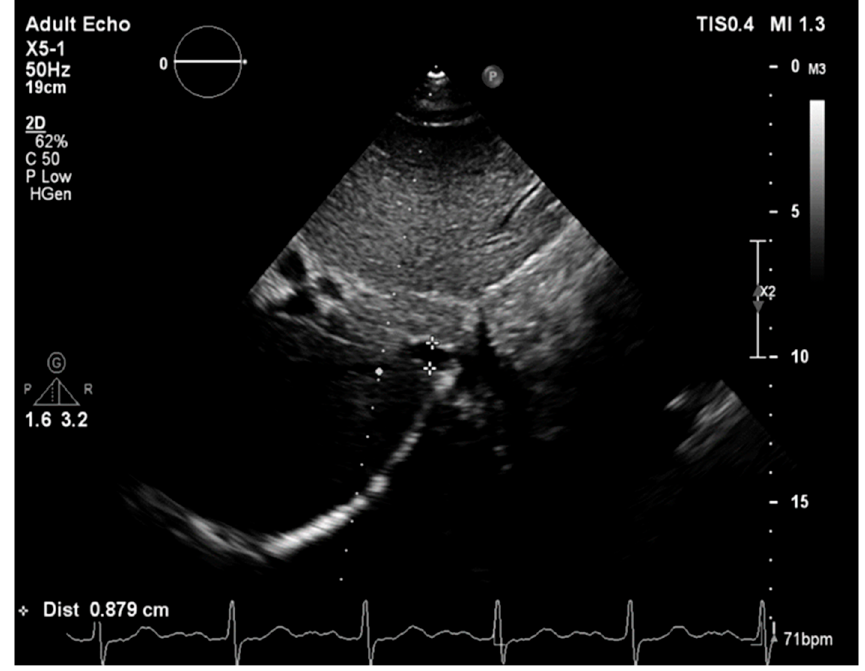
Figure A2. Echocardiographic assessment of left ventricular diastolic dysfunction. E—early mitral inflow velocity; A—late mitral inflow velocity (due to atrial contraction); e’—early diastolic mitral annular velocity; LAVI—left atrial volume indexed to body surface area; TRV—tricuspid valve re- gurgitation maximal velocity’ * septal early diastolic mitral annular velocity; ** lateral early diastolic mitral annular velocity.